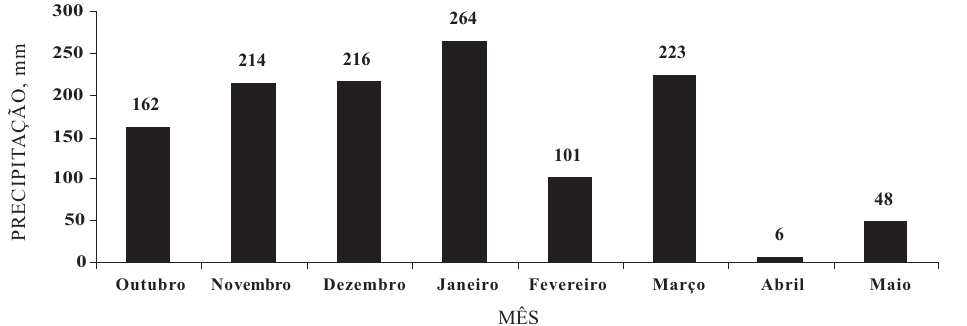
Figura 1. Precipitação mensal ocorrida durante a condução do experimento, de outubro de 2004 a maio de 2005. Rio Verde, GO,